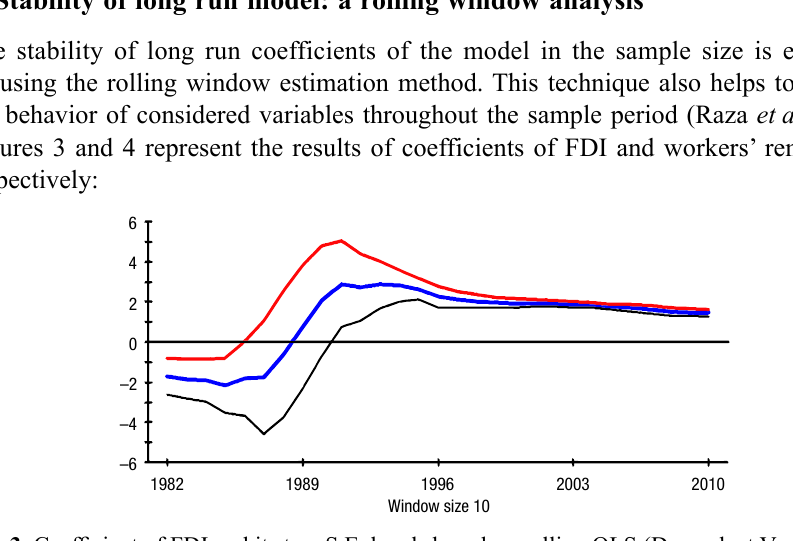
Fig. 3. Coefficient of FDI and its two S.E. bands based on rolling OLS (Dependent Variable: PS)